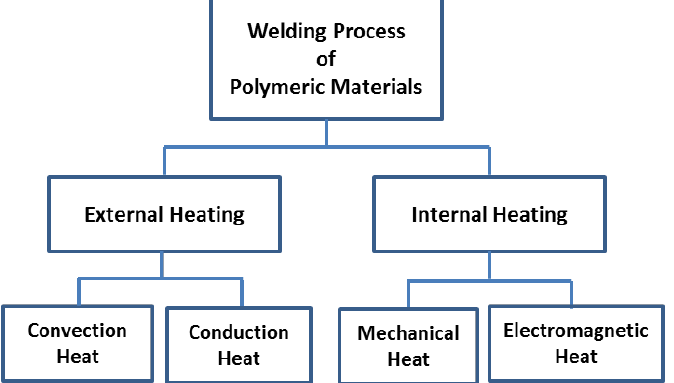
Figure 6. Classification of welding techniques for polymeric materials. The concept has been redesign on the basis of ref. [6].